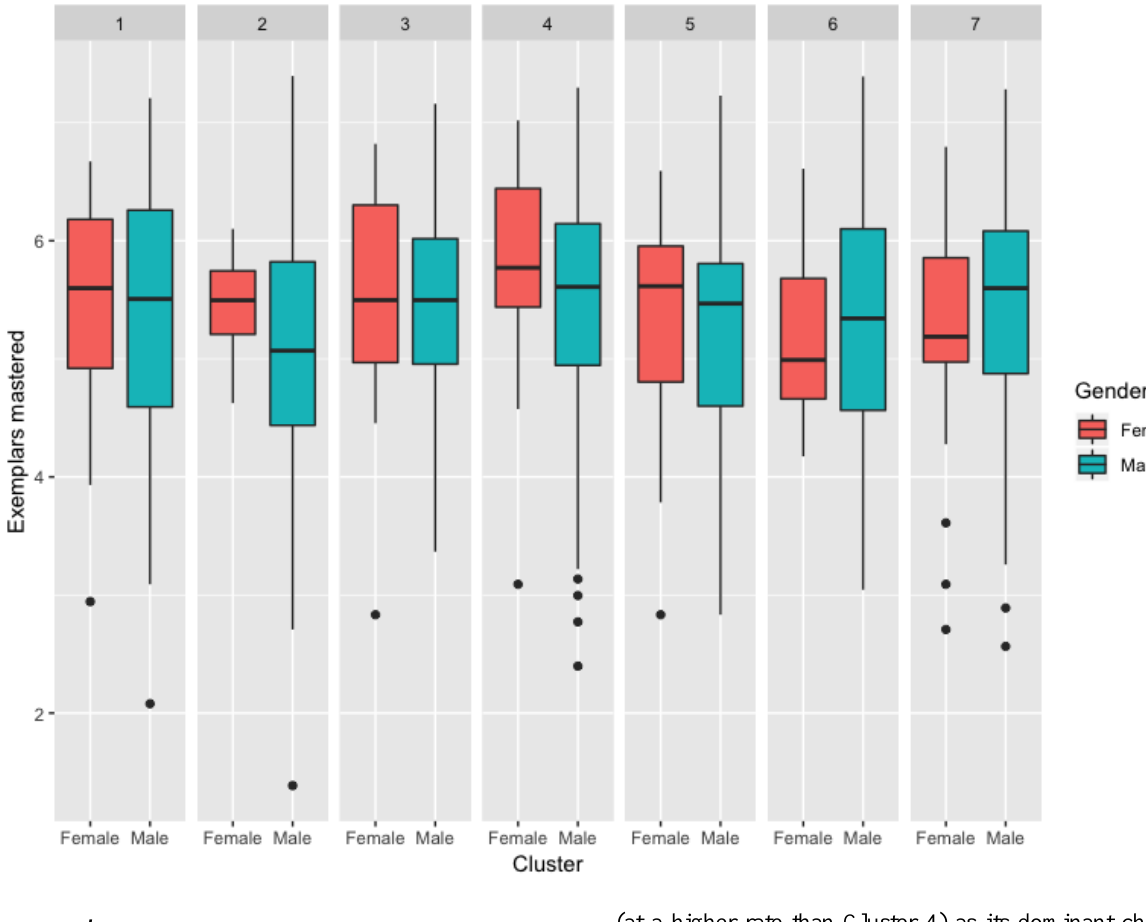
Figure 6. Box plots for each cluster and gender. The whiskers represent the minimum and maximum values. The line across each box is the median. The top of the box represents the third quartile. The bottom of the box represents the first quartile. Any points on the graph represent outliers in the